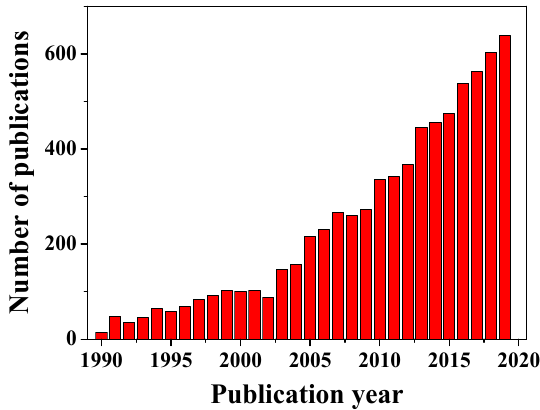
Figure 1. The increasing number of papers in the field of hydrogen gas sensors from 2001 to 2020 (internet search on the Web of Science, 15 March 2020). Keywords for search: hydrogen gas sensor.